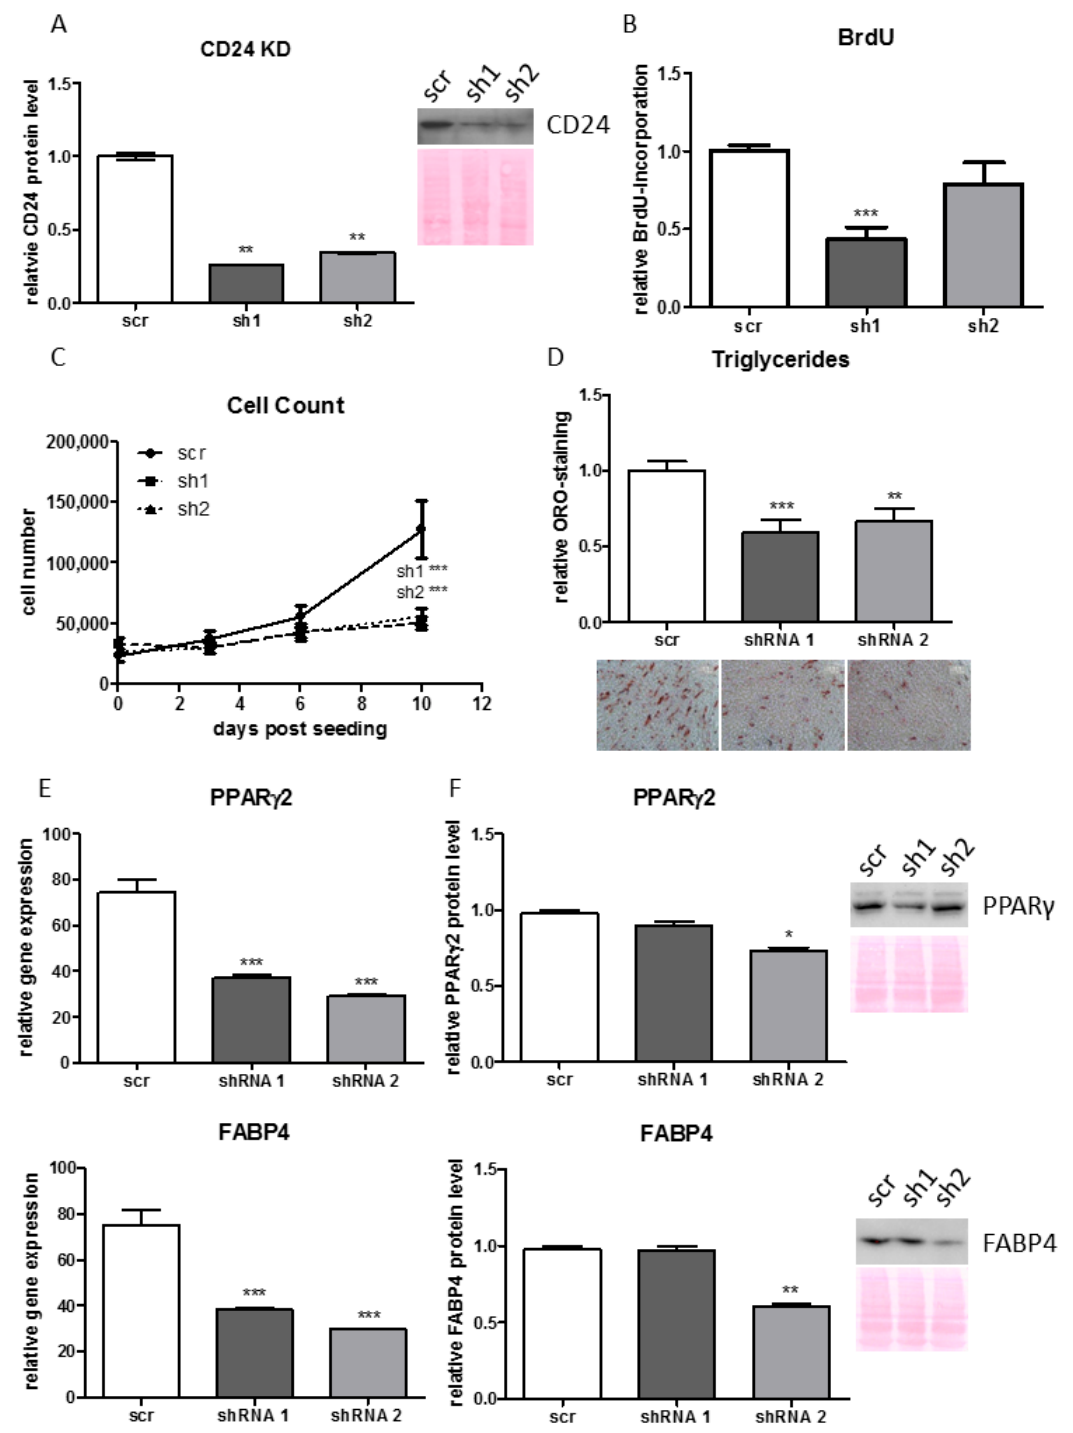
Figure 6. Impact of shRNA mediated CD24 Knock Down (KD) on proliferation and adipogenesis in human ASCs. ( A ) CD24 KD was performed in ASCs routinely isolated by the plastic adherence protocol and validated by Western Blot analysis. ( B ) Proliferation measured by BrdU incorporation. ( C ) Proliferation measured by cell counting. ( D – F ) Monitoring of adipogenic differentiation status of CD24 KD ASCs on day 14 post induction of adipogenesis. ( D ) Triglyceride accumulation measured by Oil-Red-O (ORO) staining. ( E ) Gene expression analysis for PPAR γ 2 and FABP4. ( F ) Western Blot analysis of PPAR γ 2 and FABP4 protein levels. Representative results in ASCs derived from 3 different donors are shown, n = 3 for technical replicates, gene expression was normalized to β -Actin. Mean+SEM is shown, unpaired student´s t -test was performed to calculate significances with * p < 0.05 ** p < 0.01 and *** p < 0.001.